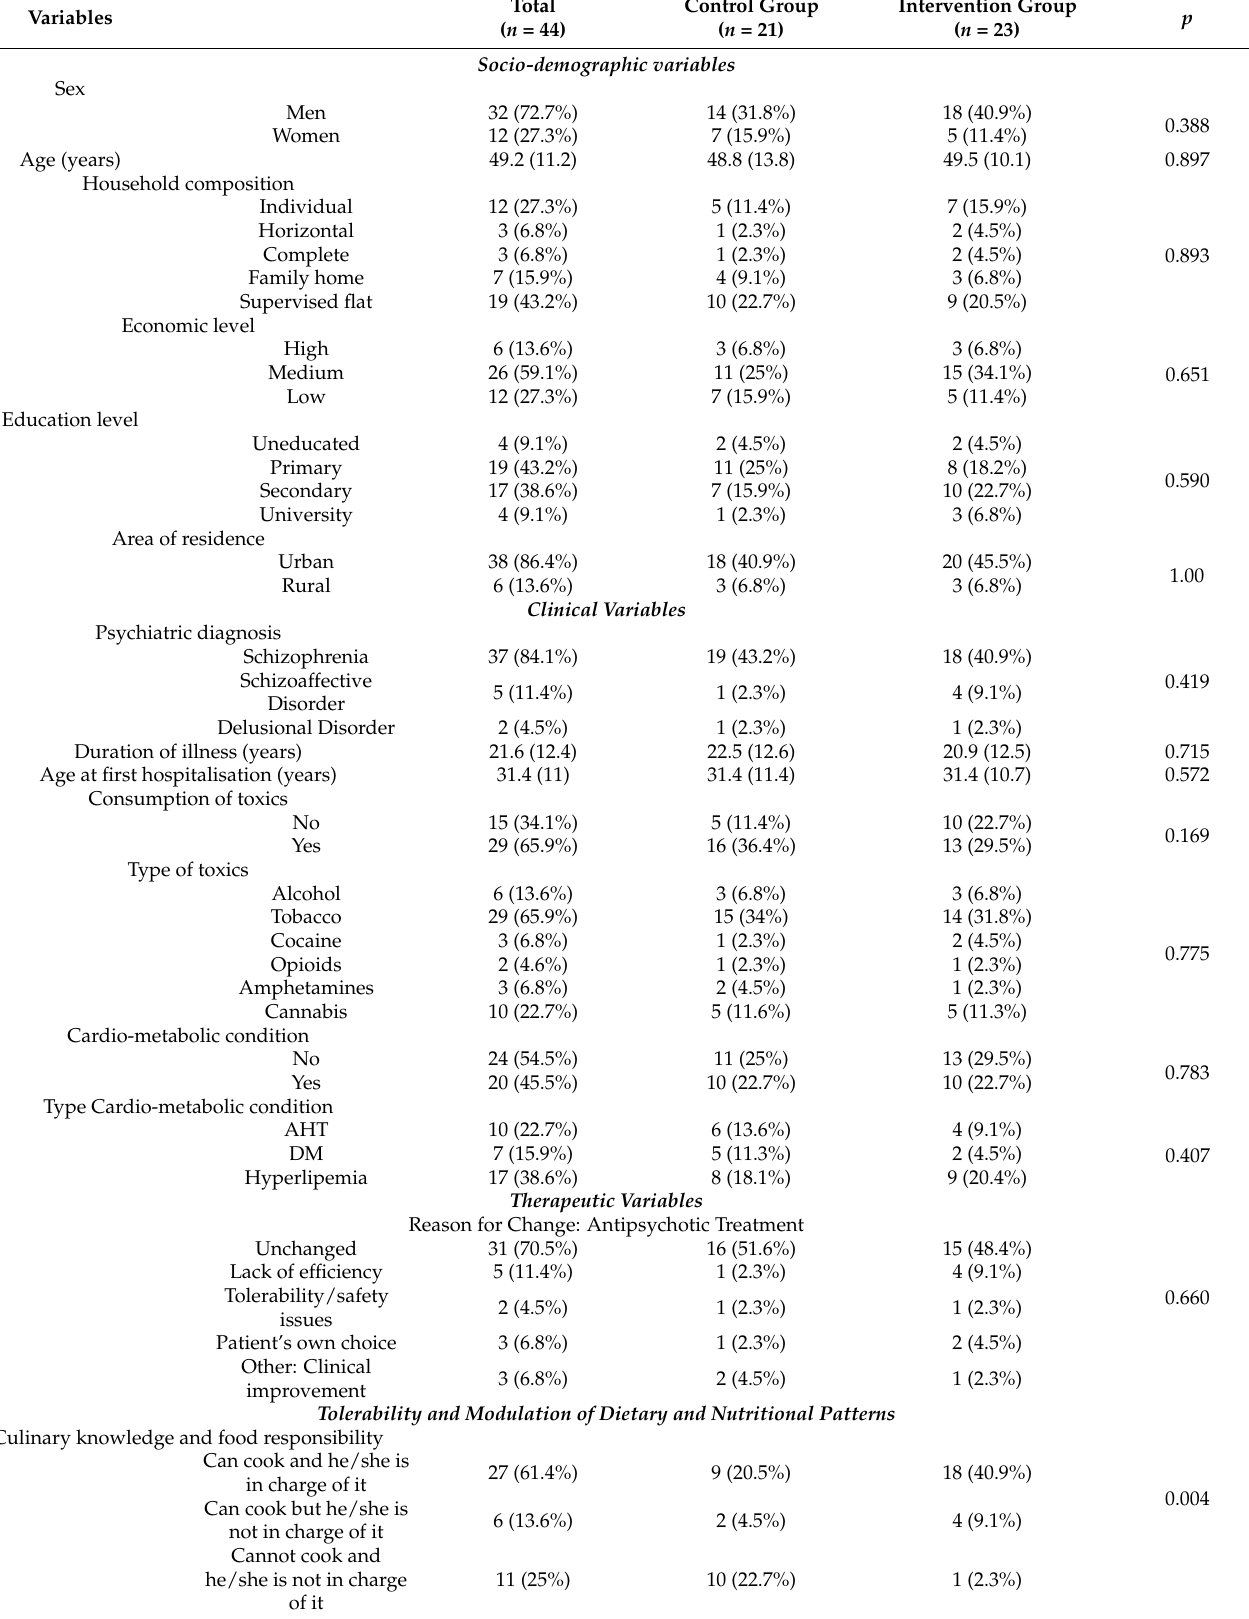
Table 1. Sample characteristics (independent variables):